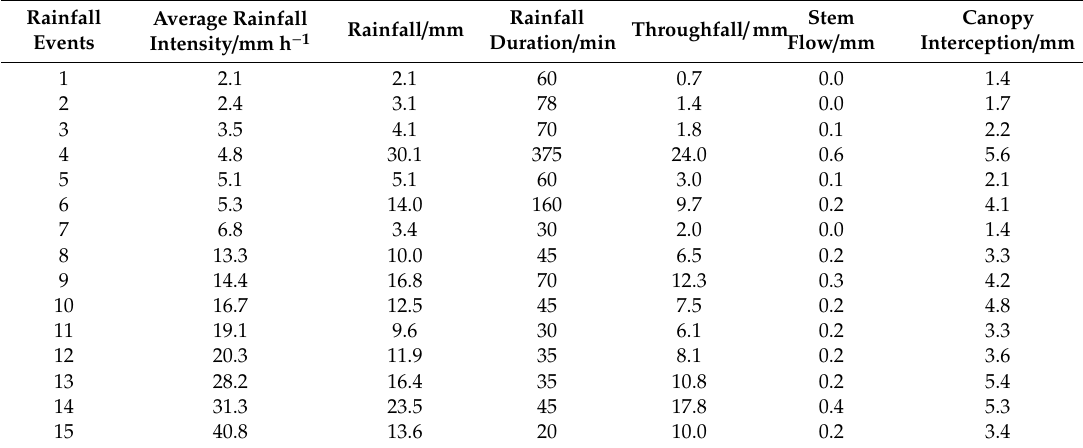
Table 1. Rainfall Table 1. Rainfall events.